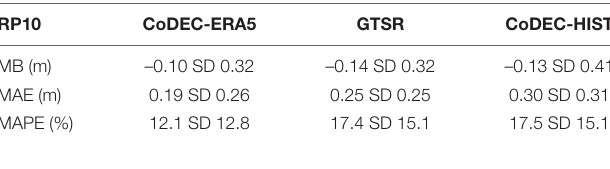
TABLE 4 | Model performance of the 1 in 10-year water levels (RP10) of the CoDEC-ERA, GTSR, and CoDEC-HIST